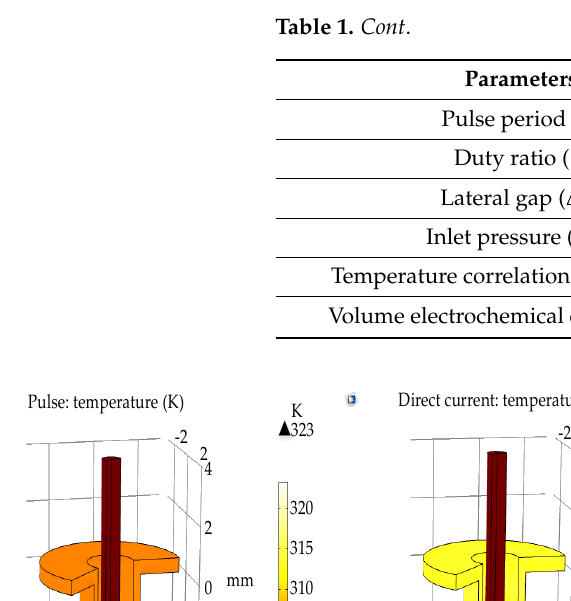
Table 1. Parameters of the simulation model.